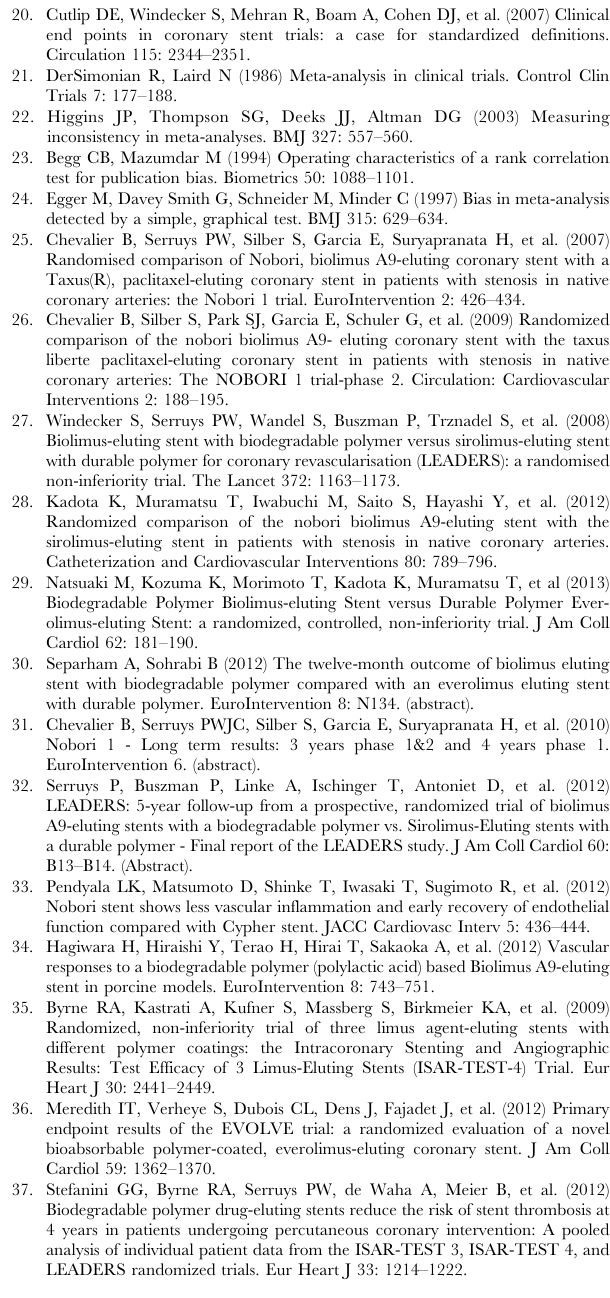
Table S2 Sensitivity analysis of the effect of exclusion of individual studies on pooled relative risks (RRs) with 95% confidence intervals